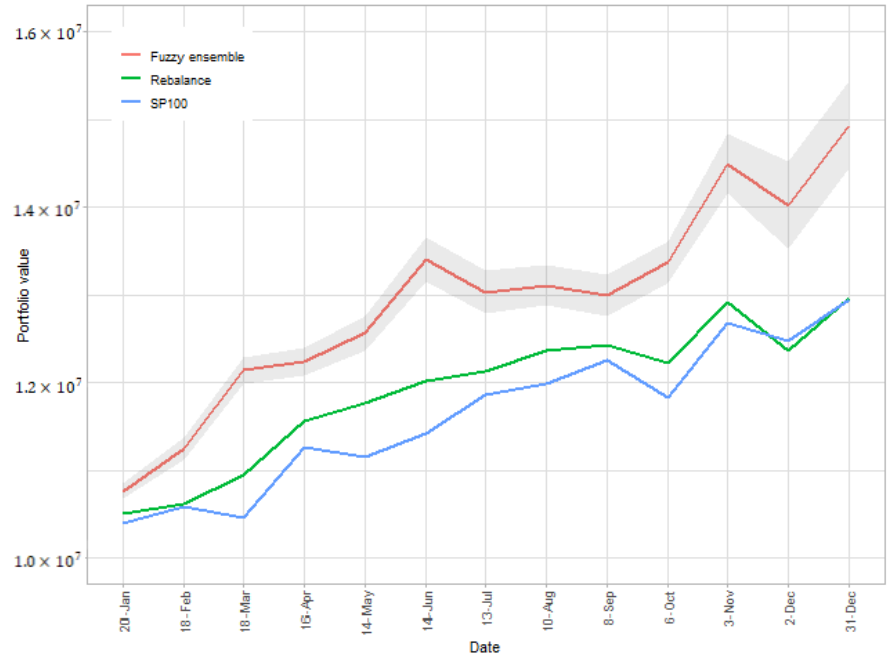
Figure 6. Time series plot with a 95% confidence band for the portfolio value of our fuzzy ensemble model compared to the SP100 index and rebalance portfolio with a starting amount of 10,000,000 USD.